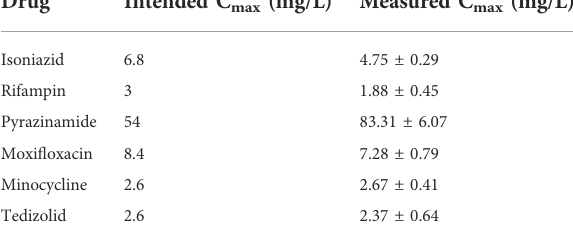
TABLE 2 Intended versus HFS-TB measured peak concentration of each drug in the regimen.